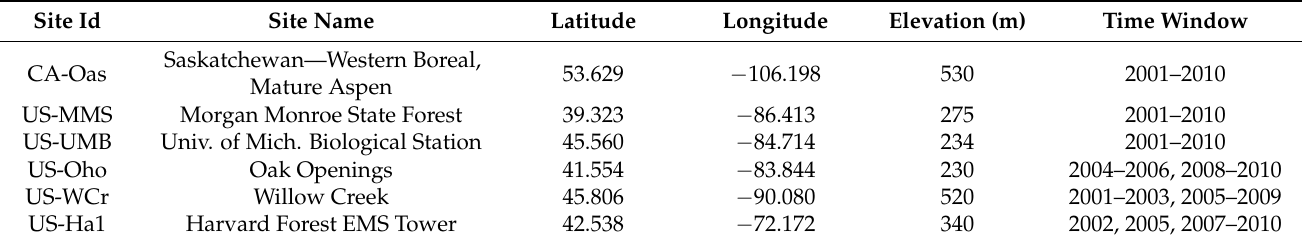
Table 1. Detail information of the flux